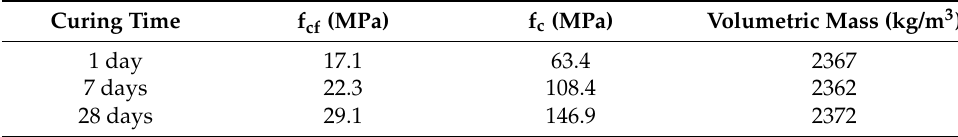
Table 4. Properties of UHPSFRC, mixture A.